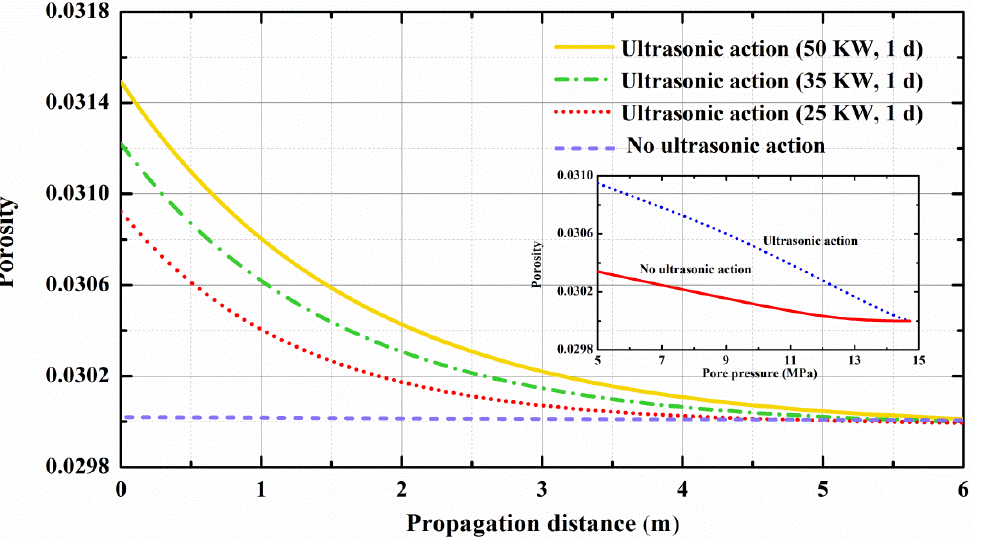
Figure 8. Simulation results of reservoir porosity changes without and with ultrasonic waves.